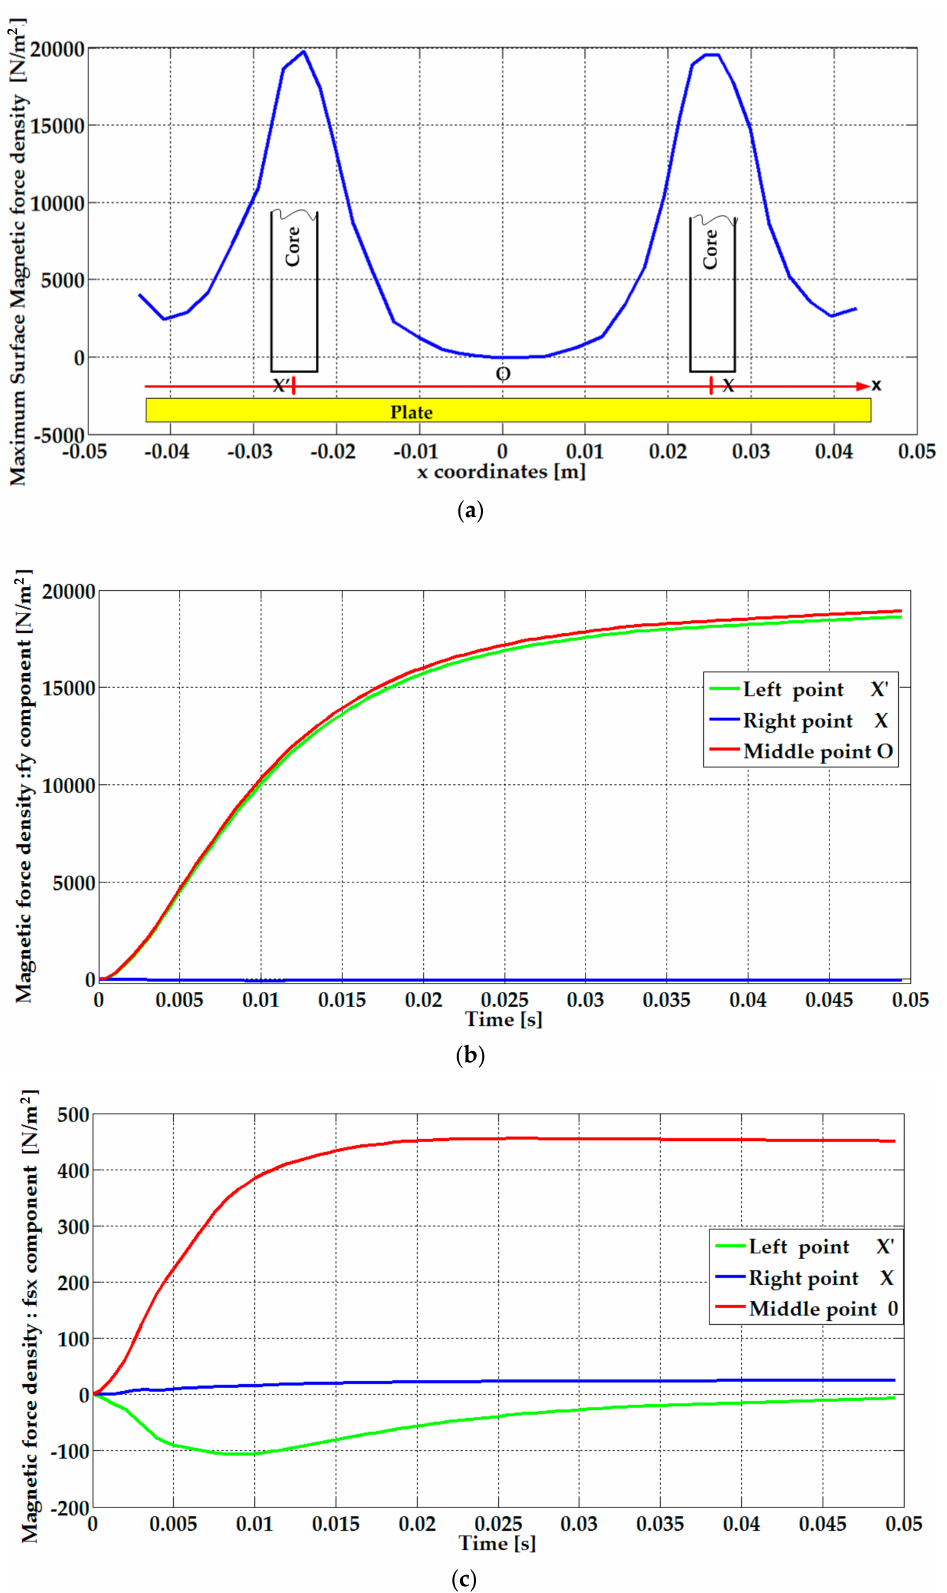
Figure 11. Surface magnetic force density components: ( a ) Maximum surface force, ( b ) Transient fs y -components, ( c ) Transient fs x